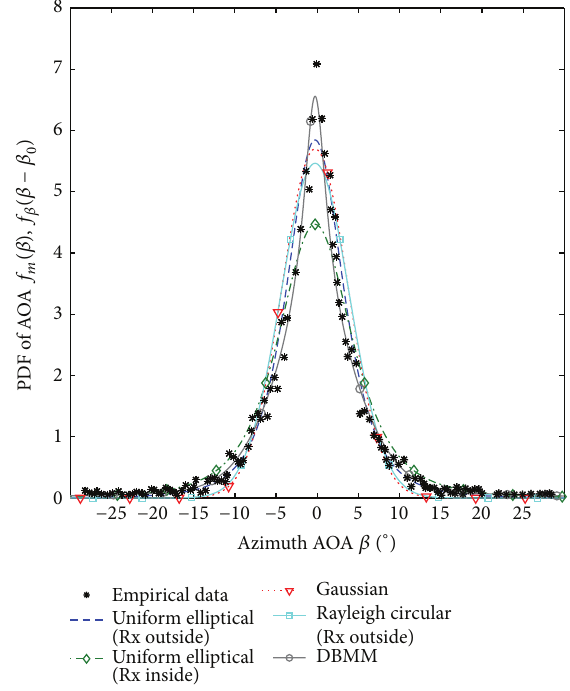
Figure10:Fittingforvariousgeometricmodelstotheempiricaldata in Pedersen et al. [1, Figure 4 ], Aarhus.